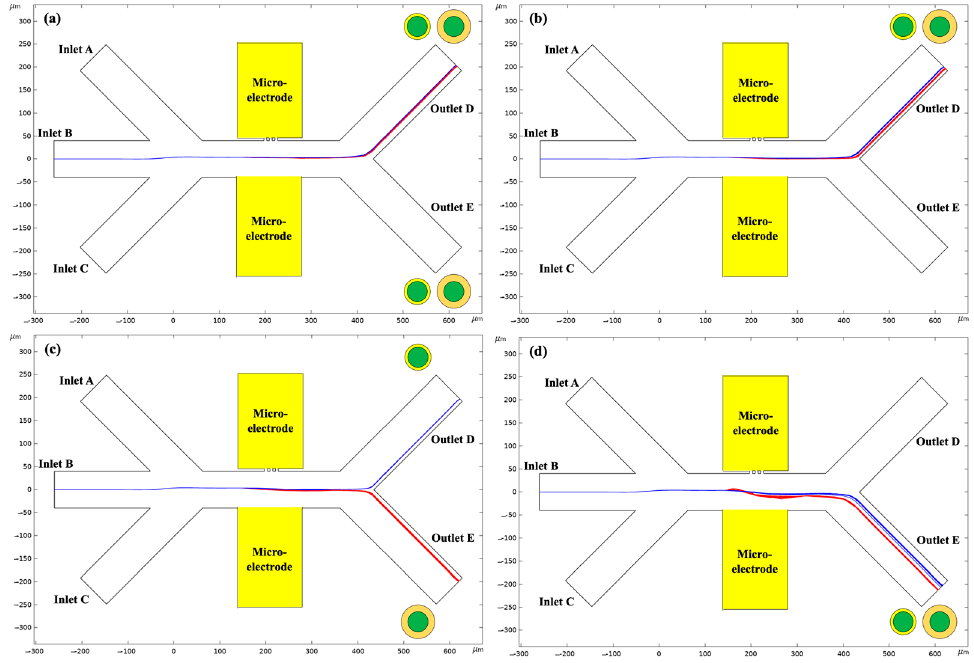
Figure 8. The migration of 3-micrometer Chlorella coated with 100% PS particles but two different PS-particle-coating thicknesses of 0.2 µm and 1 µm, respectively, varying with the applied electric voltage: ( a ) 10 V, ( b ) 20 V, ( c ) 30 V, ( d ) 50 V. The electrical conductivity of the medium used in this study was 𝜎 (cid:3040) = 1 × 10 − 7 S/m.